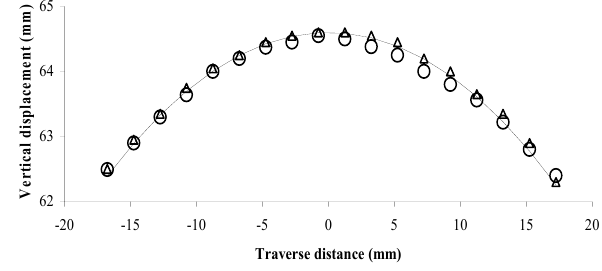
Fig. 5 . Profile of test optic as determined by Talysurf profilometer. Open circles and triangles Fig. 5. Profile of test optic as determined by Talysurf profilometer. show measurements of the profile in orthogonal directions. Also shown (solid line) is the best Open circles and triangles show measurements of the profile in or- fit circle to the profiles (radius 64.6 mm). The maximum deviation of the optic profile from thogonal directions. Also shown (solid line) is the best fit circle to the profiles (radius 64.6mm). The maximum deviation of the optic the best fit is of order 190 µm. profile from the best fit is of order 190 µ m.